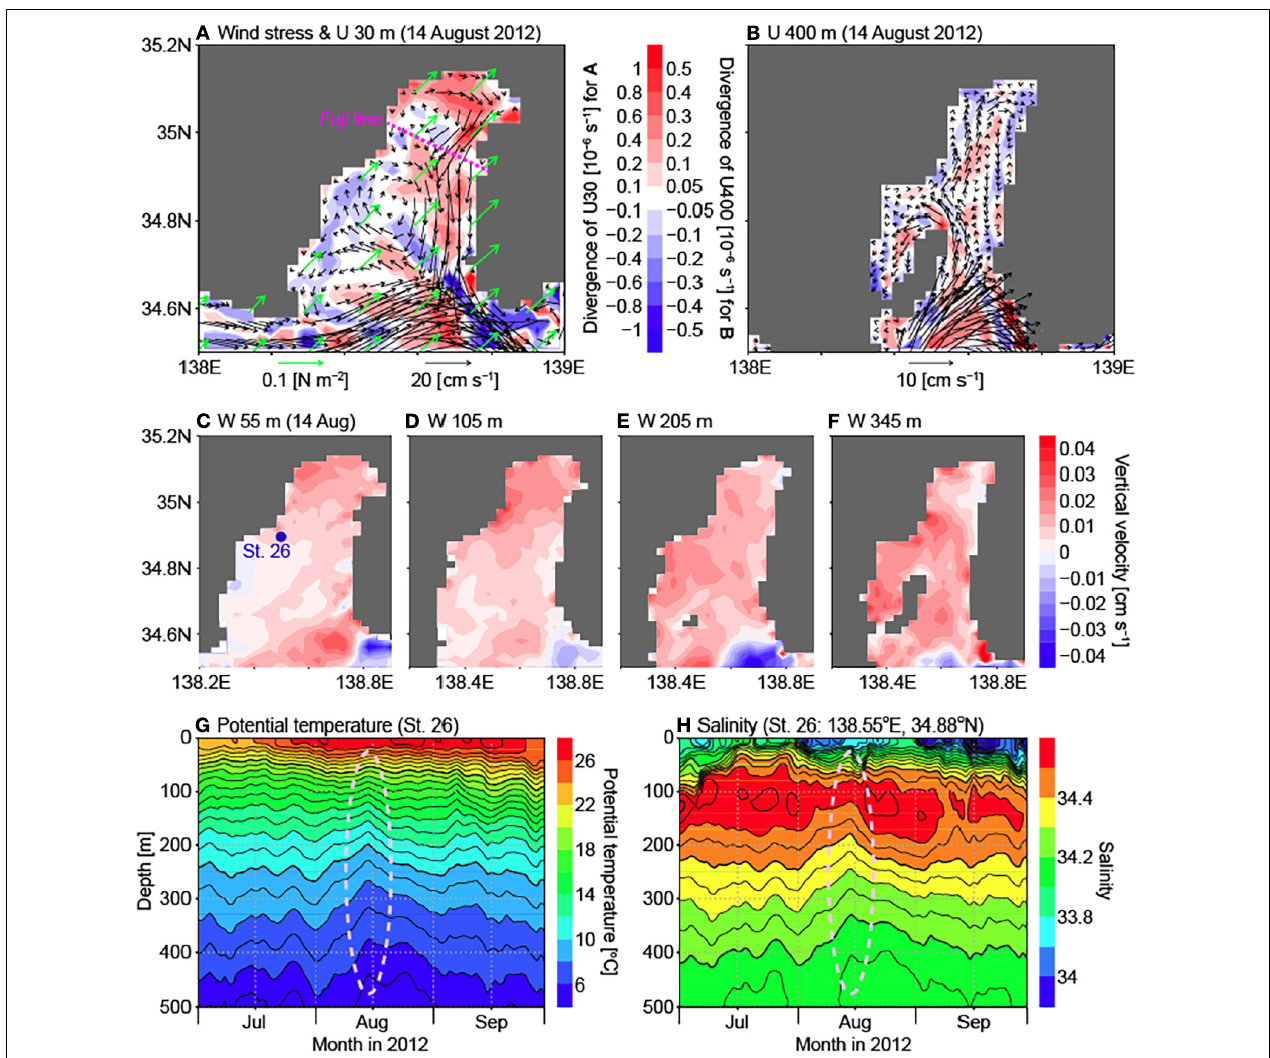
FIGURE 14 | (A) Distributions of surface wind stresses (green arrows), horizontal velocities (black arrows) and horizontal velocity divergences (shading) at 30 m depth. (B) Distributions of horizontal velocities (black arrows) and horizontal velocity divergences (shading) at 400 m depth. (C–F) Distributions of vertical velocities (positive upward) at 55, 105, 205, and 345 m depths, respectively. These distributions (A–F) are for the peak day of the positive EOF3 event, 14 August 2012. (G,H) Time evolutions of potential temperature and salinity profiles at Station 26 of Nakamura (1982) [138.55 ◦ E, 34.88 ◦ N; blue closed circle in (C) ]. Potential temperature and salinity changes during the EOF3 event are indicated by dashed ellipses. Purple dashed line in (A) denotes the ordinary track of the sightseeing ferry Fuji